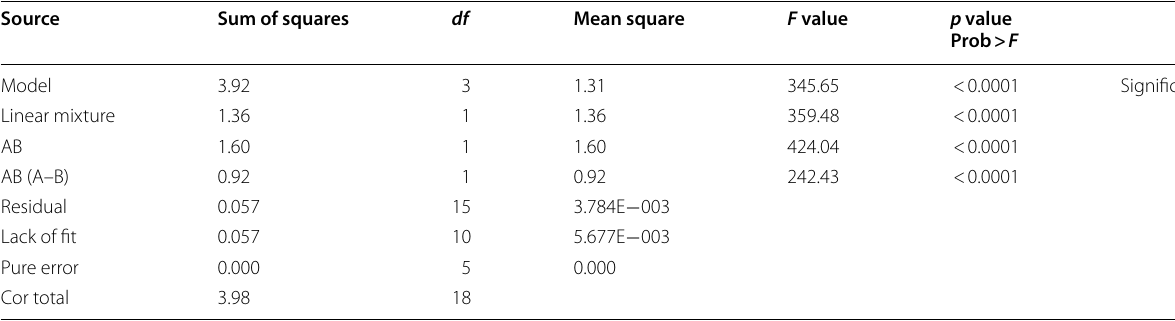
Table 1 Software generated ANOVA table considering retention time of metsulfuron-methyl as Response 1